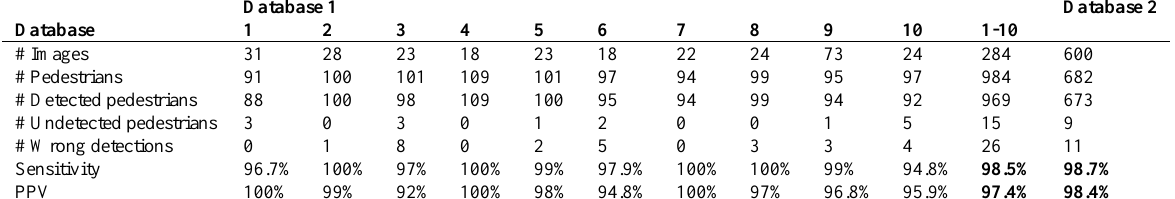
Table 7. Result of proposed method on databases 1 and 2 after applying Gaussian noise.